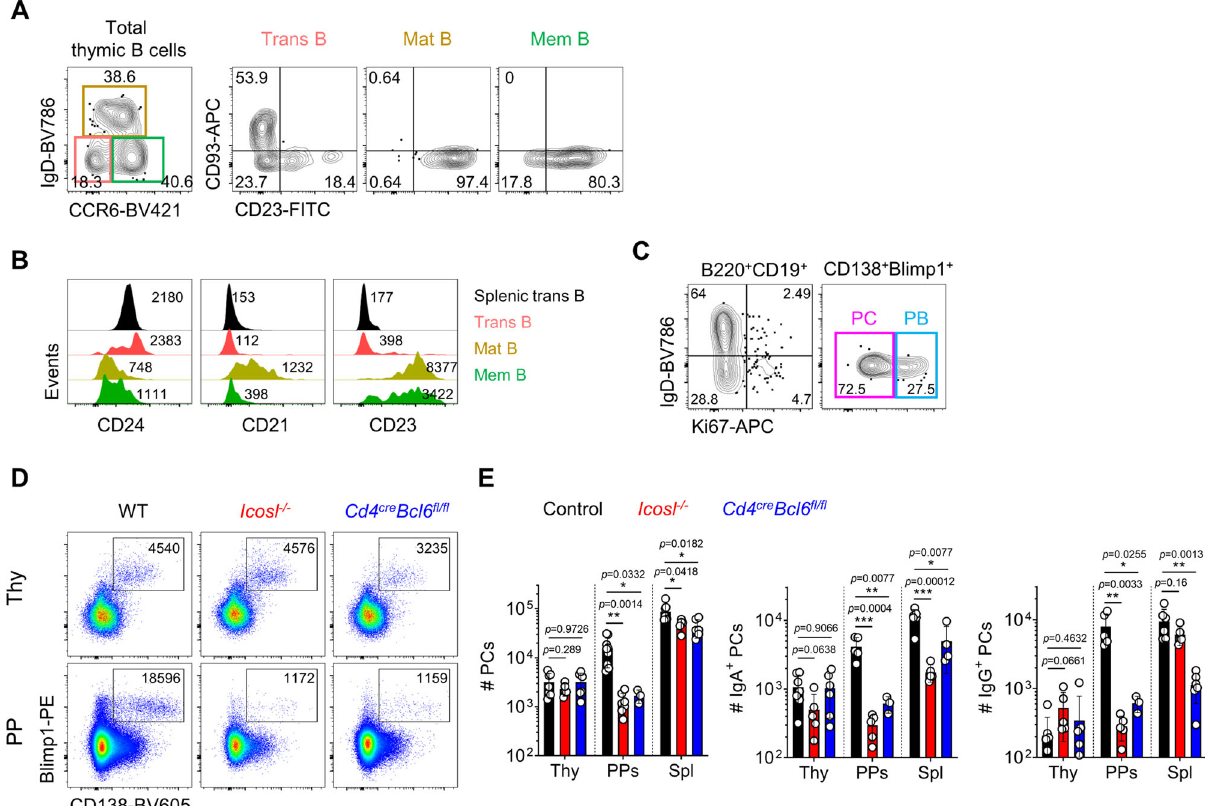
Fig. 5 Various stages of B cells develop in the thymus without GC reaction. A Representative FACS plots show IgD − CCR6 − transitional B, IgD + CCR6 lo mature B, and IgD − CCR6 hi memory B cells from total B220 + CD19 + thymic B cells (left). Expression levels of CD93 and CD23 from indicated cells were shown (right three panels). Numbers indicate frequencies of cells in adjacent gates. B The histogram shows MFI of CD24, CD21, and CD23 expression from indicated cells. Numbers indicate MFI value. C Representative FACS plots show Ki67 expression in B220 + CD19 + B cells (left) and CD138 + Blimp1 + PCs (right) from total and CD138 enriched thymocytes, respectively. D , E Representative dot plots show PCs from CD138 enriched thymocytes (upper) and total cells in PPs (lower) from indicated mice ( D ). The number of cells was shown in adjacent gates. Results are from three independent experiments. Graphs show statistical analysis ( N = 3 – 9 for each group) ( E ). Data are presented as mean values± SD. Each dot represents an individual mouse. Unpaired two-tailed t -tests were used for comparison. *** p < 0.001, ** p < 0.01, * p < 0.05. Not signi fi cant ( p > 0.05). PB Plasmablast; PC Plasma cell; Thy Thymus; Spl Spleen; PPs Peyer ’ s patches; mLN Mesenteric lymph node; BM Bone